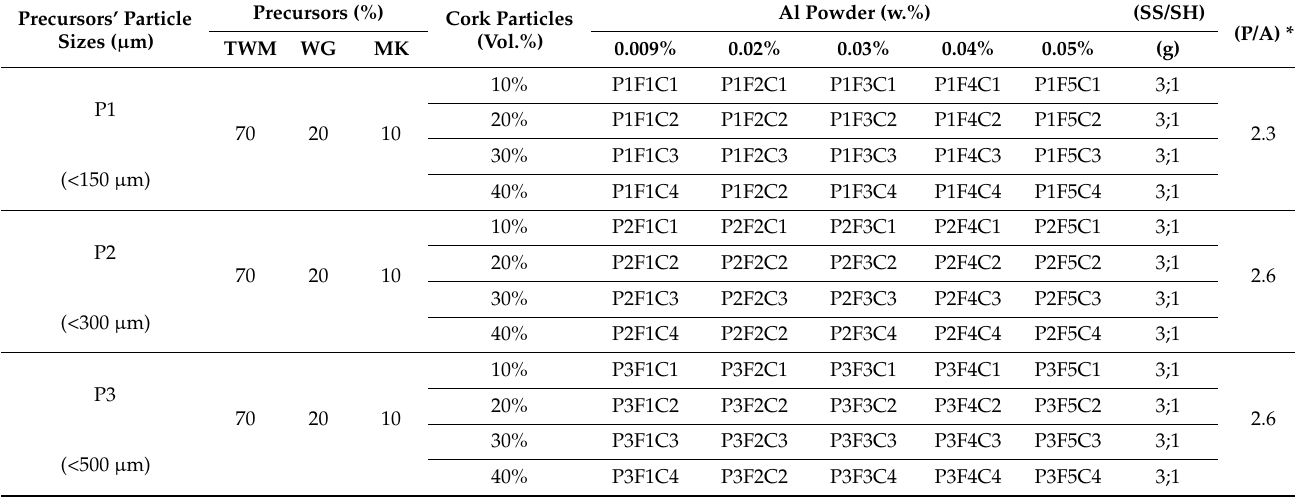
Table 3. Detailed composition of alkali-activated lightweight foamed materials